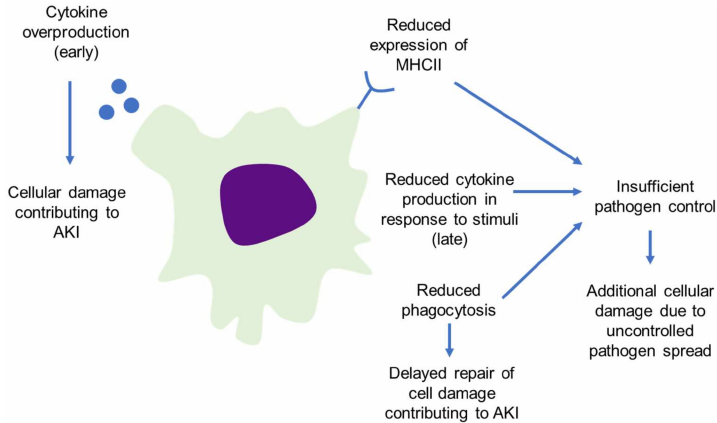
Figure 3. Macrophage dysfunctions linked to increased sepsis